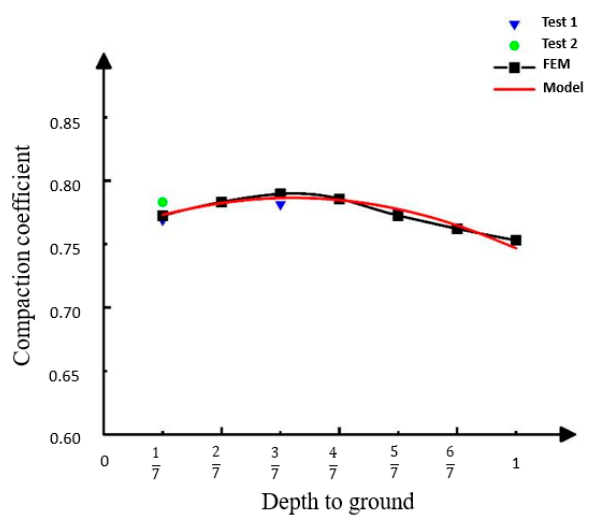
Figure 11. The relationship between the compaction coefficient at the centroid and m.